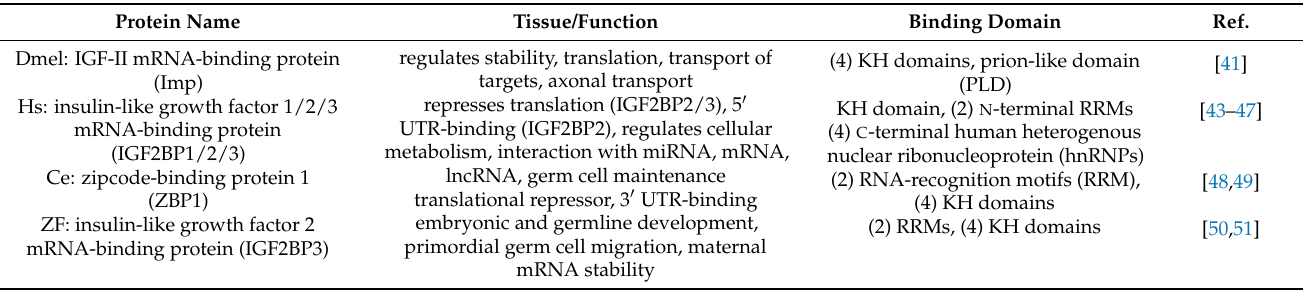
Table 1. Conserved RNA-binding proteins. Table showing RBPs conserved in Drosophila melanogaster (Dmel), humans (Hs), Caenorhabditis elegans (Ce), and Dario rerio (ZF). Resident tissue, function, binding domains, and associated references for each RBP are also